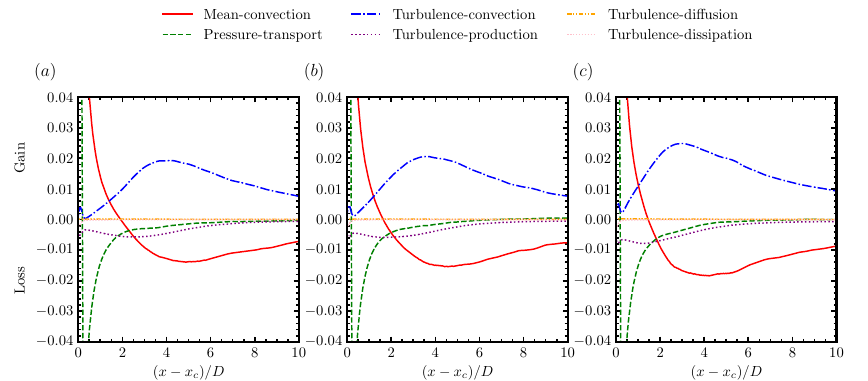
Figure 11. Different terms in the MKE budget equation for the stand-alone turbine case under inflow1 ( a ), inflow2 ( b ) and inflow3 ( c ). Different terms are normalized using U hub and D .